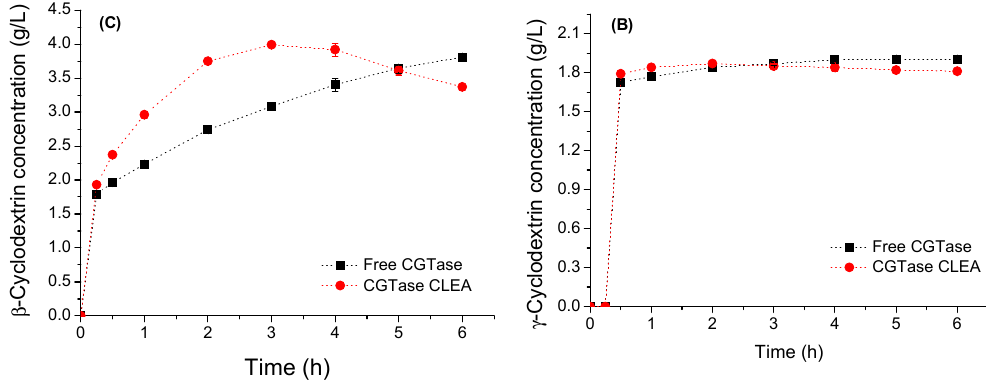
Figure 8. Batch assays of ( A ) total CDs, ( B ) α -CD, ( C ) β -CD, and ( D ) γ -CD production at 50 ° C and pH 6.0 for 6 h, catalyzed by free CGTase (5.0 U/g starch) and CLEAs of CGTase (5.0 U/g starch). Substrate: 2.0% (w/v) pre-hydrolyzed starch (DE 1.4%). One Unit (U) correspond the activity of CGTase measured with 0.5% (w/v) dextrin as substrate, as described in Section 3.2.